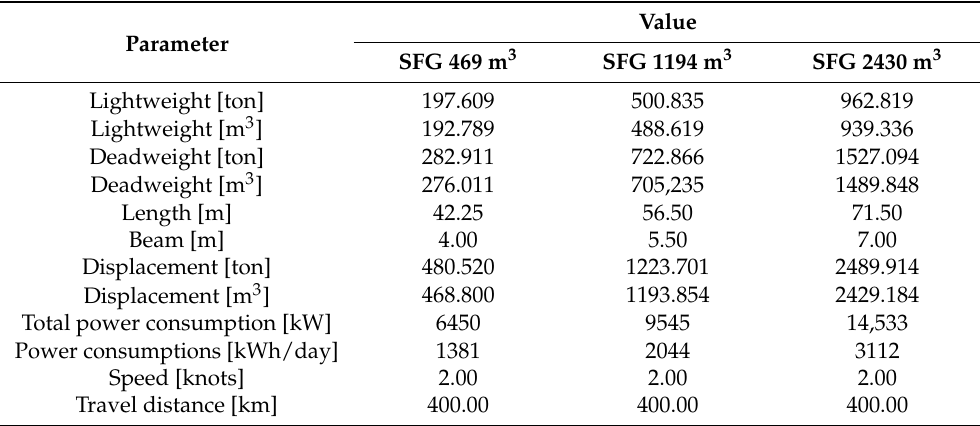
Table 8. The main parameters of the final derived SFG